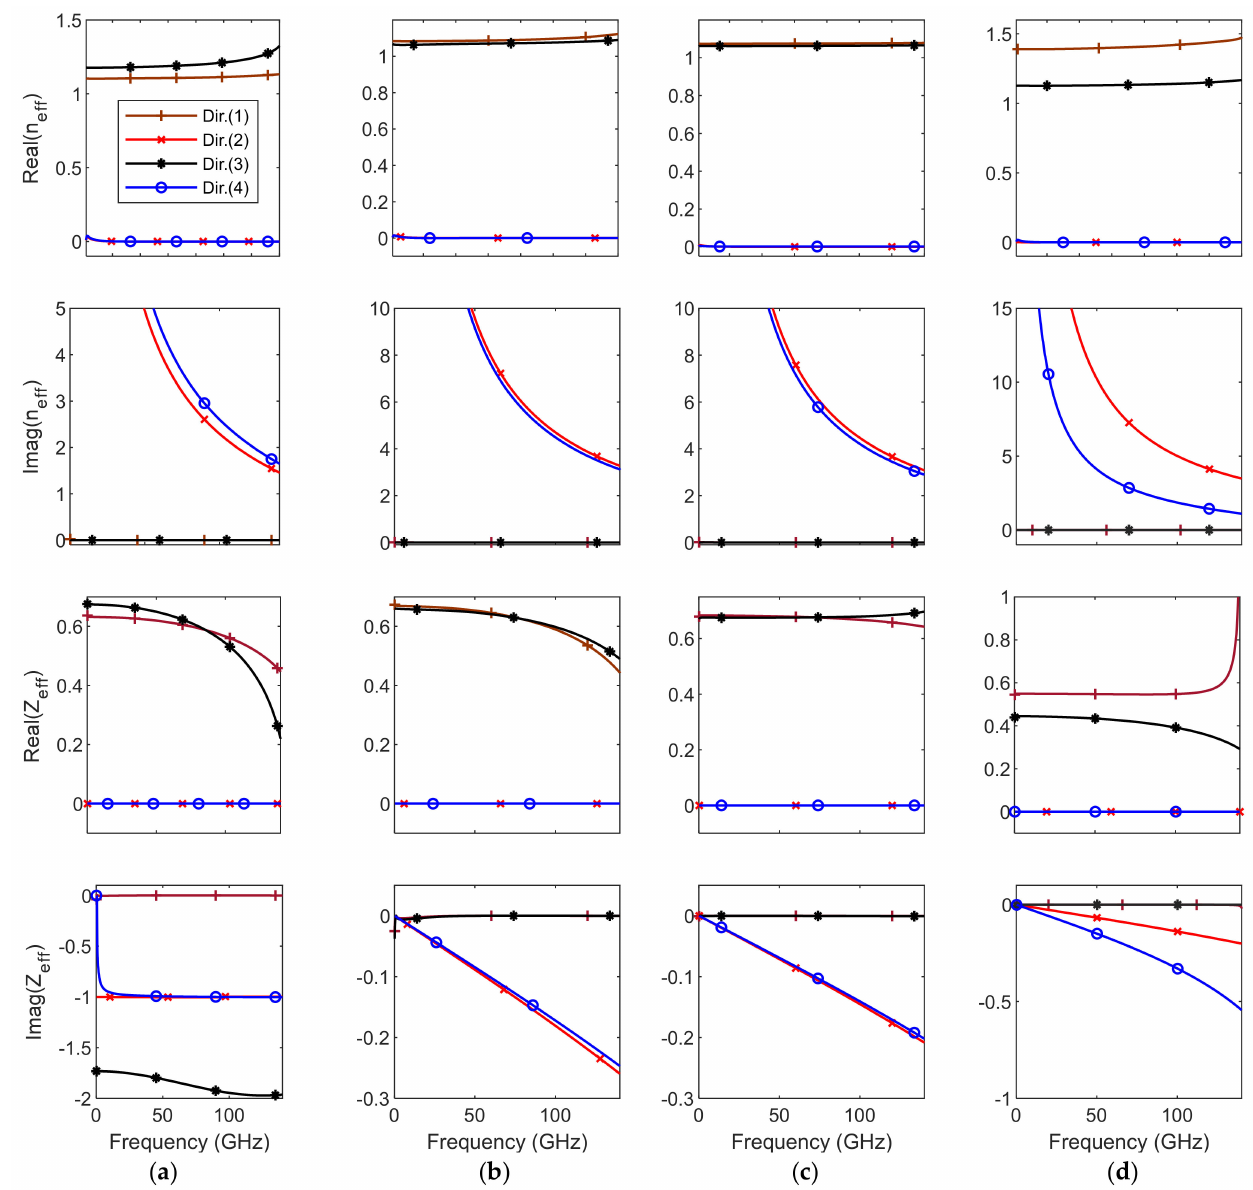
Figure 3. The extracted n eff and Z eff parameters of unit cells A , B , C and D at four propagation directions. ( a ) Unit cell A , ( b ) unit cell B , ( c ) unit cell C , and ( d ) unit cell D